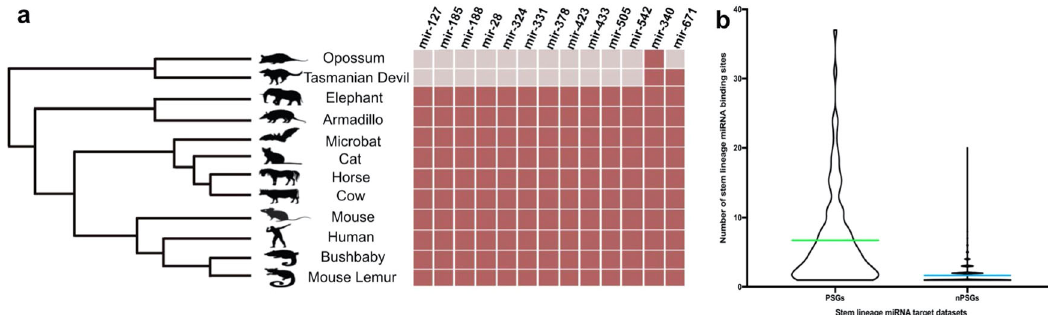
Fig. 2 Phylogenetic distribution of the miRNA families and their levels of targeting in positively selected genes. a Phylogenetic distribution of miRNA families speci fi c to therian and eutherian mammals. The mammal phylogeny displays the species sampled in our analysis. The corresponding matrix shows the presence (dark red) or absence (pale grey) of miRNA families across the species sampled. b Violin plot comparing the number of target miRNA binding sites from the core miRNA toolkit per transcript in the 84 genes that underwent positive selection on the stem Eutherian lineage (PSGs) (left) compared sampled sets of non-positively selected but randomly sampled genes that are targeted by the core toolkit of miRNAs (nPSG) (right). For each of the 84 PSGs, the mean number of predicted miRNA binding sites was determined for each target transcript in humans (depicted in green). This was compared to the mean number of binding sites for each of the nPSGs (depicted in blue). The mean number of binding sites was determined to be signi fi cantly different between the two datasets when p ≤ 0.05, two-sample t -test with